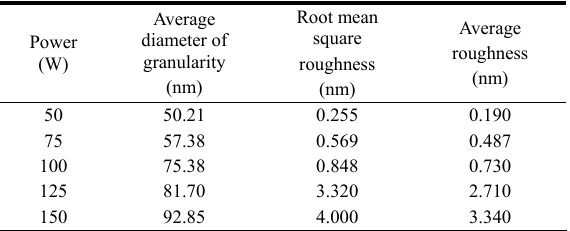
Table 2 AFM data of (Ti6Al4V) thin films deposited on the glass substrate at different RF powers.